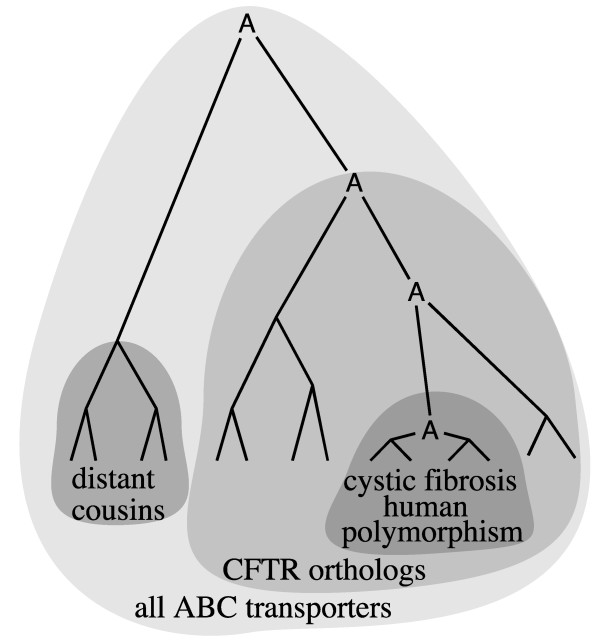
Phylogenetic schematic highlighting the relationships between ABC transporters, mammalian CFTRs, and human CFTR polymorphisms based on sequence variation.